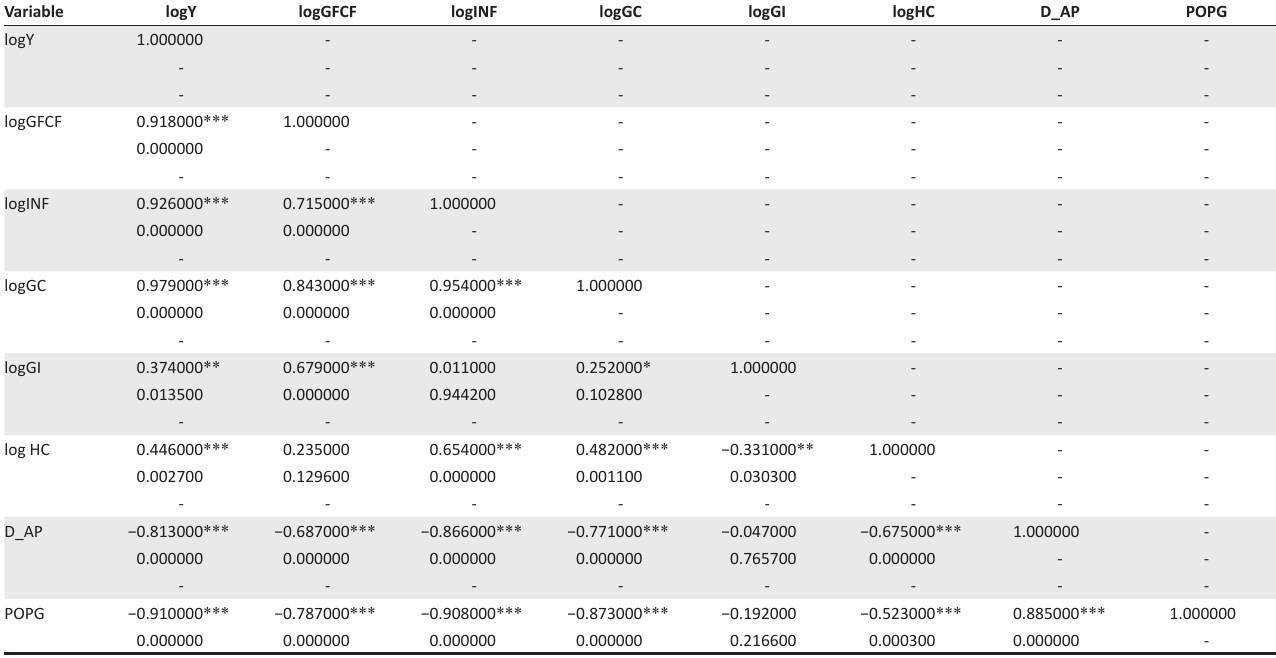
TABLE 1-A1: Correlation probability.